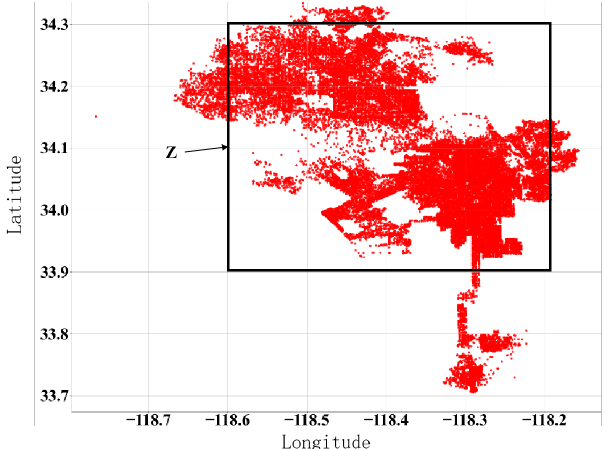
Figure 6. The overall spatial crime